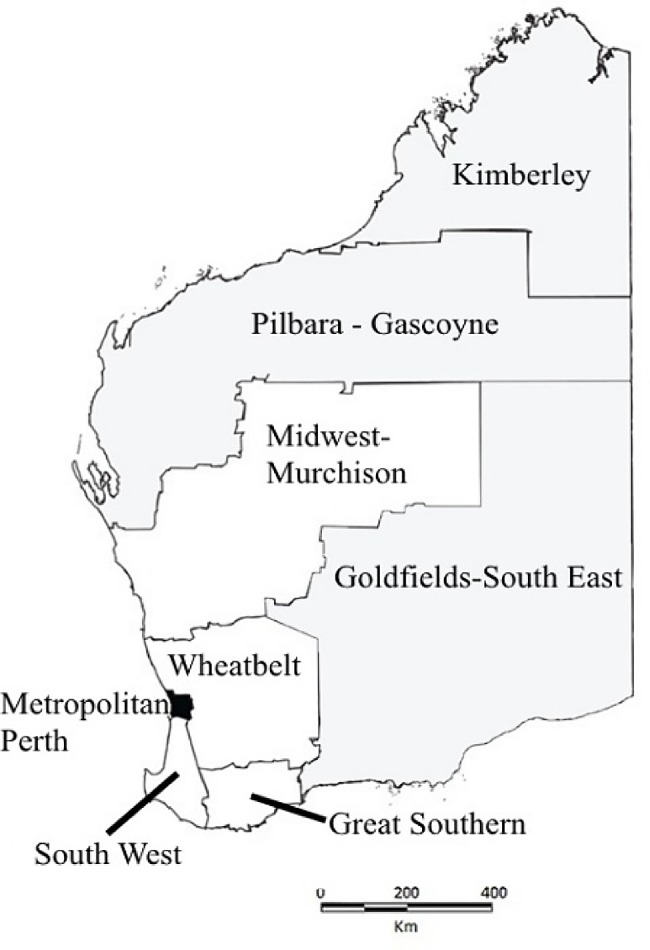
Map of Western Australia.Shows metropolitan (black), rural (white) and remote (grey) areas.